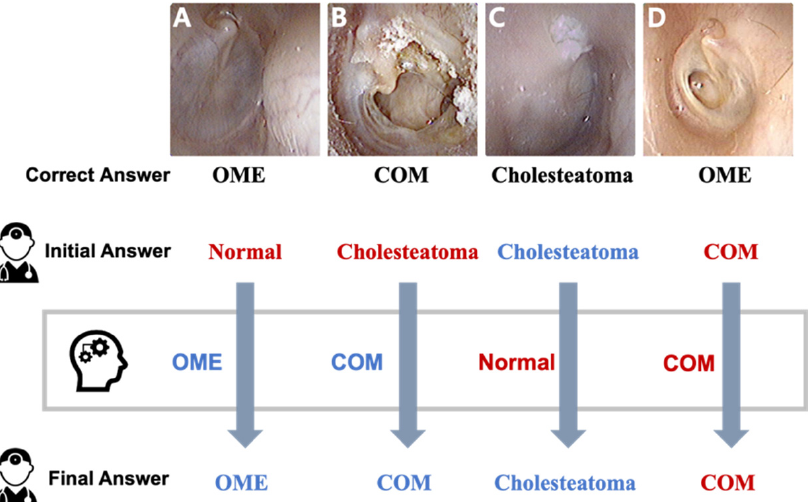
Figure 7. Representative cases in tympanic membrane images. ( A , B ) Many resident physicians changed to the correct answer with the advice of the machine learning network. ( C ) All resident physicians diagnosed cholesteatoma correctly despite wrong advice. ( D ) Resident physicians and the machine learning misdiagnosed OME as COM. OME: otitis media with effusion. COM: Chronic otitis media.